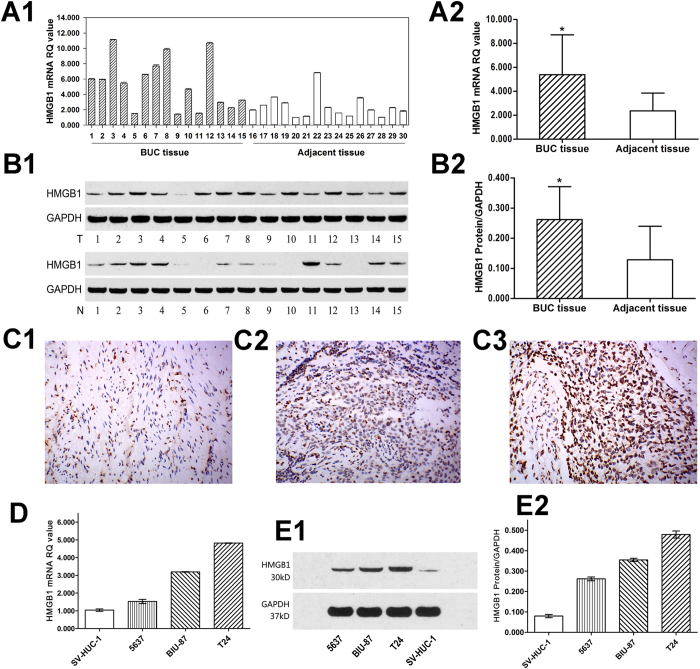
HMGB1 expression is up-regulated in BUC tissues and cell lines.Figure 1A1 and A2: qRT-PCR was performed to evaluate the levels of HMGB1 mRNA in 15 paired fresh BUC and adjacent non-tumour tissues. *P  < 0.05, compared with adjacent non-tumour tissue. Figure 1B1 and B2: The overexpression of HMGB1 protein was detected by WB in 15 BUC and paired adjacent non-tumour tissues (T: BUC tissue; N: adjacent non-tumour tissue). *P  < 0.05, compared with adjacent non-tumour tissue. Figure 1C1, C2, and C3: The expression of HMGB1 in BUC and adjacent non-tumour tissues was examined by IHC (×200). HMGB1 staining was much weaker in the majority of adjacent non-tumour tissues (Fig. 1C1). Among BUC samples, low expression of HMGB1 was detected only in 13/30 (43.3%) of BUC tissues (Fig. 1C2), while high expression of HMGB1 was apparent in 17/30 (56.7%) of BUC tissues (Fig. 1C3). Figure 1D, E1, and E2: qRT-PCR and WB were performed to measure the levels of HMGB1 mRNA and protein in different BUC cell lines. Pairwise significant differences were detected among them, with the HMGB1 expression levels all significantly higher than in the SV-HUC-1 cell line (all P < 0.001). Furthermore, among these BUC cells, the expression level of HMGB1 was highest in T24 cells and the lowest in 5637 cells. The display of cropped gels is used to improve the clarity and conciseness of the presentation, and all the cropped gels have been run under the same experimental conditions.